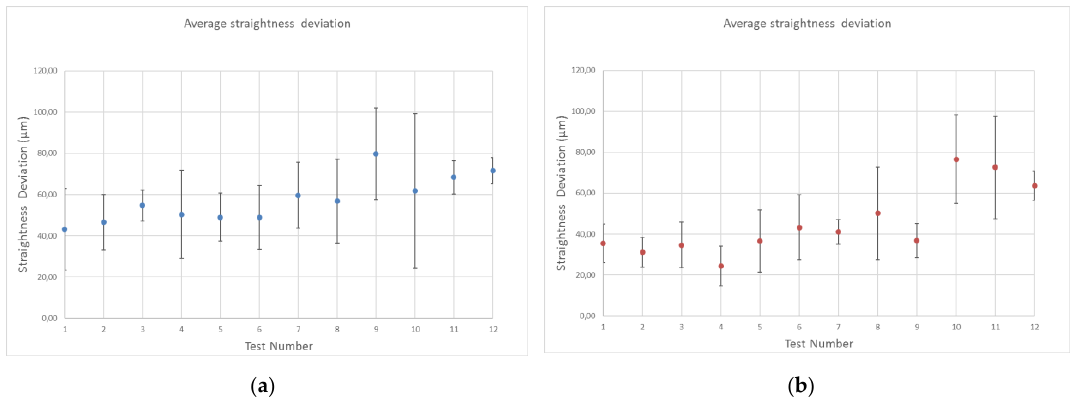
Figure 17. Straightness deviations results on: ( a ) UNS A97075/CFRP configuration; ( b ) CFRP/UNS A97075 configuration.